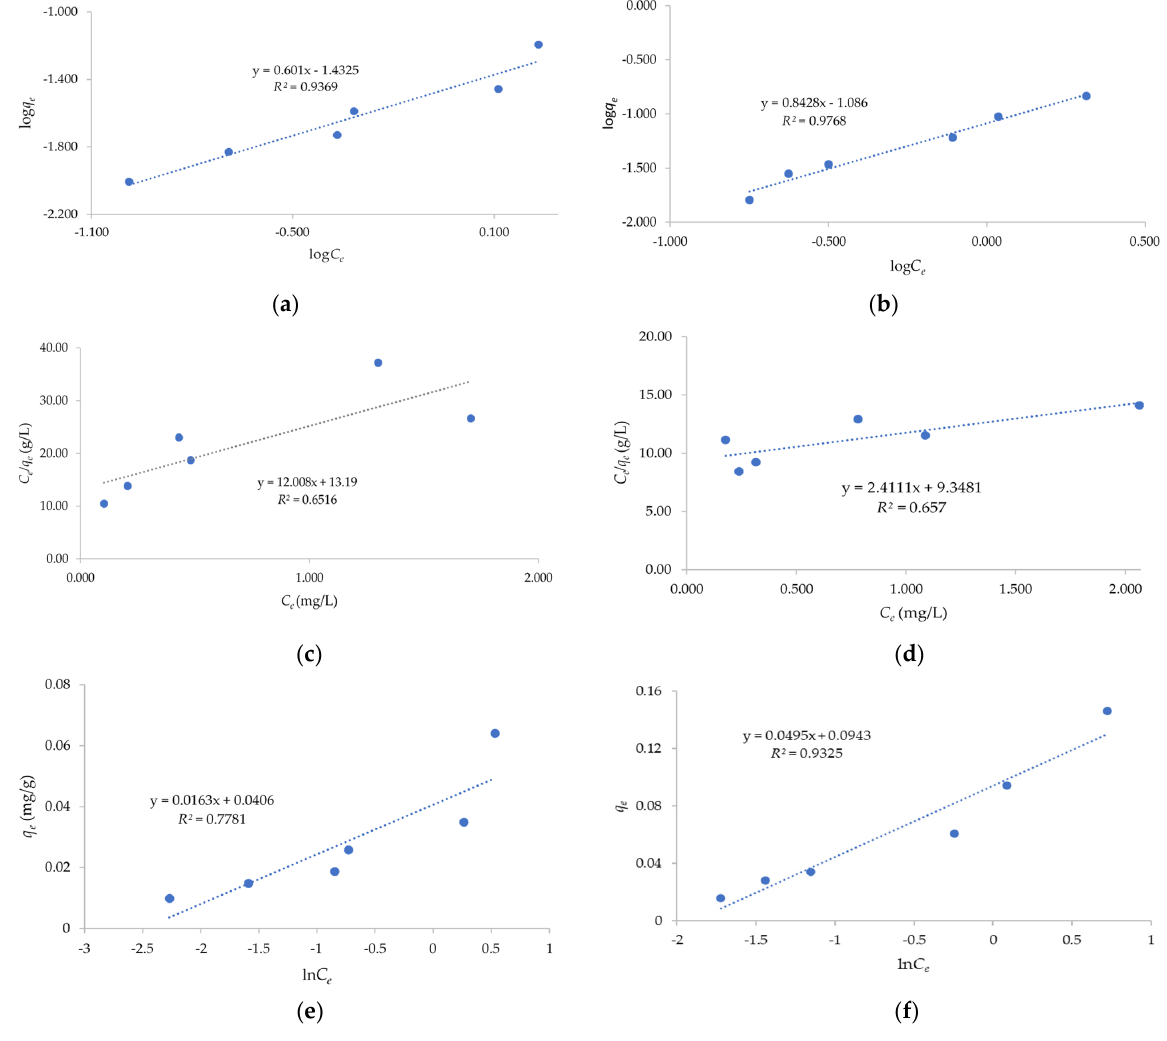
Figure 13. Adsorption isotherms of Freundlich, Langmuir, and Temkin for N–PPF and C–PPF. Freundlich isotherm for ( a ) N–PPF and ( b ) C–PPF; Langmuir isotherm for ( c ) N–PPF and ( d ) C–PPF; Temkin isotherm for ( e ) N–PPF and ( f ) C–PPF. Table 3. Comparison of isotherm parameters for Fe(III) adsorption on C–PPF and N–PPF sorbents. Biosorbent Langmuir Isotherm Freundlich Isotherm Temkin Isotherm